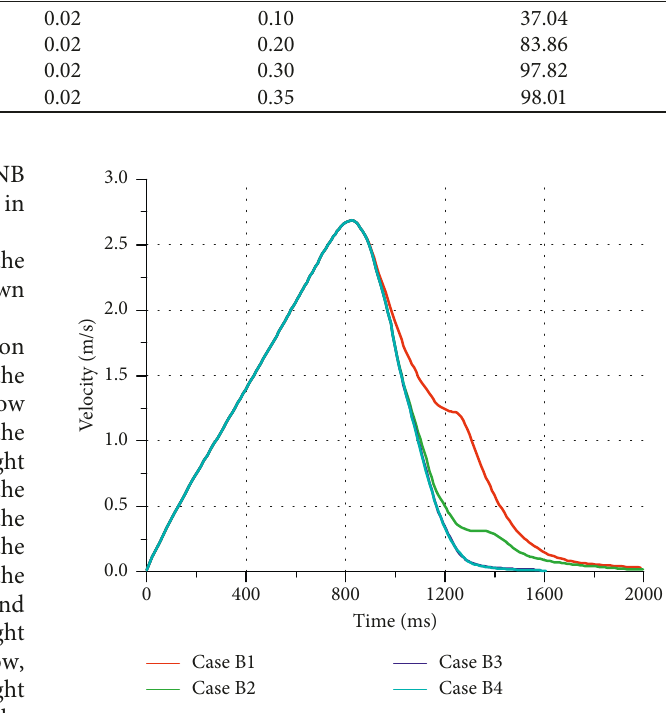
Figure 11: Time history of the granular flow velocity when RNB with different heights was